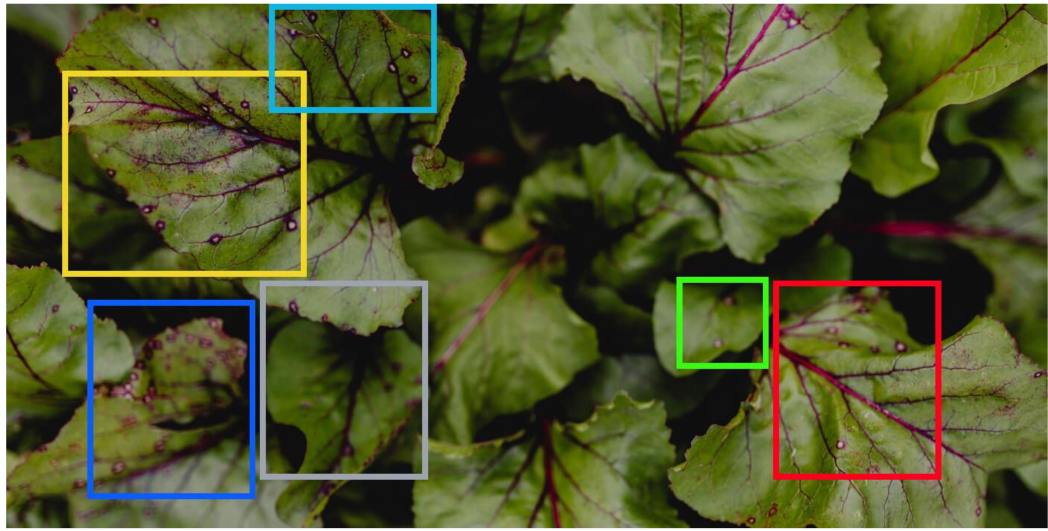
Figure 9. Plant disease detection